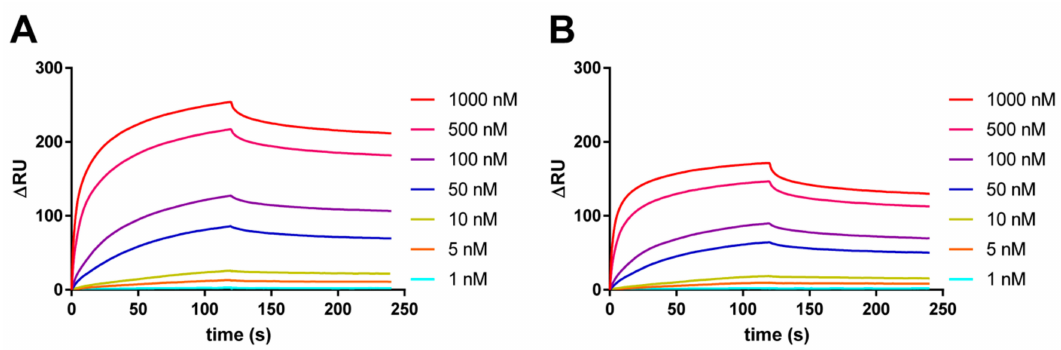
Figure 1. Binding analysis of VEGF165 to VEGF G4 DNA by SPR. Representative SPR binding signal of unmethylated ( A ) or methylated VEGF G4 DNA ( B ) to VEGF165 immobilized on a CM5